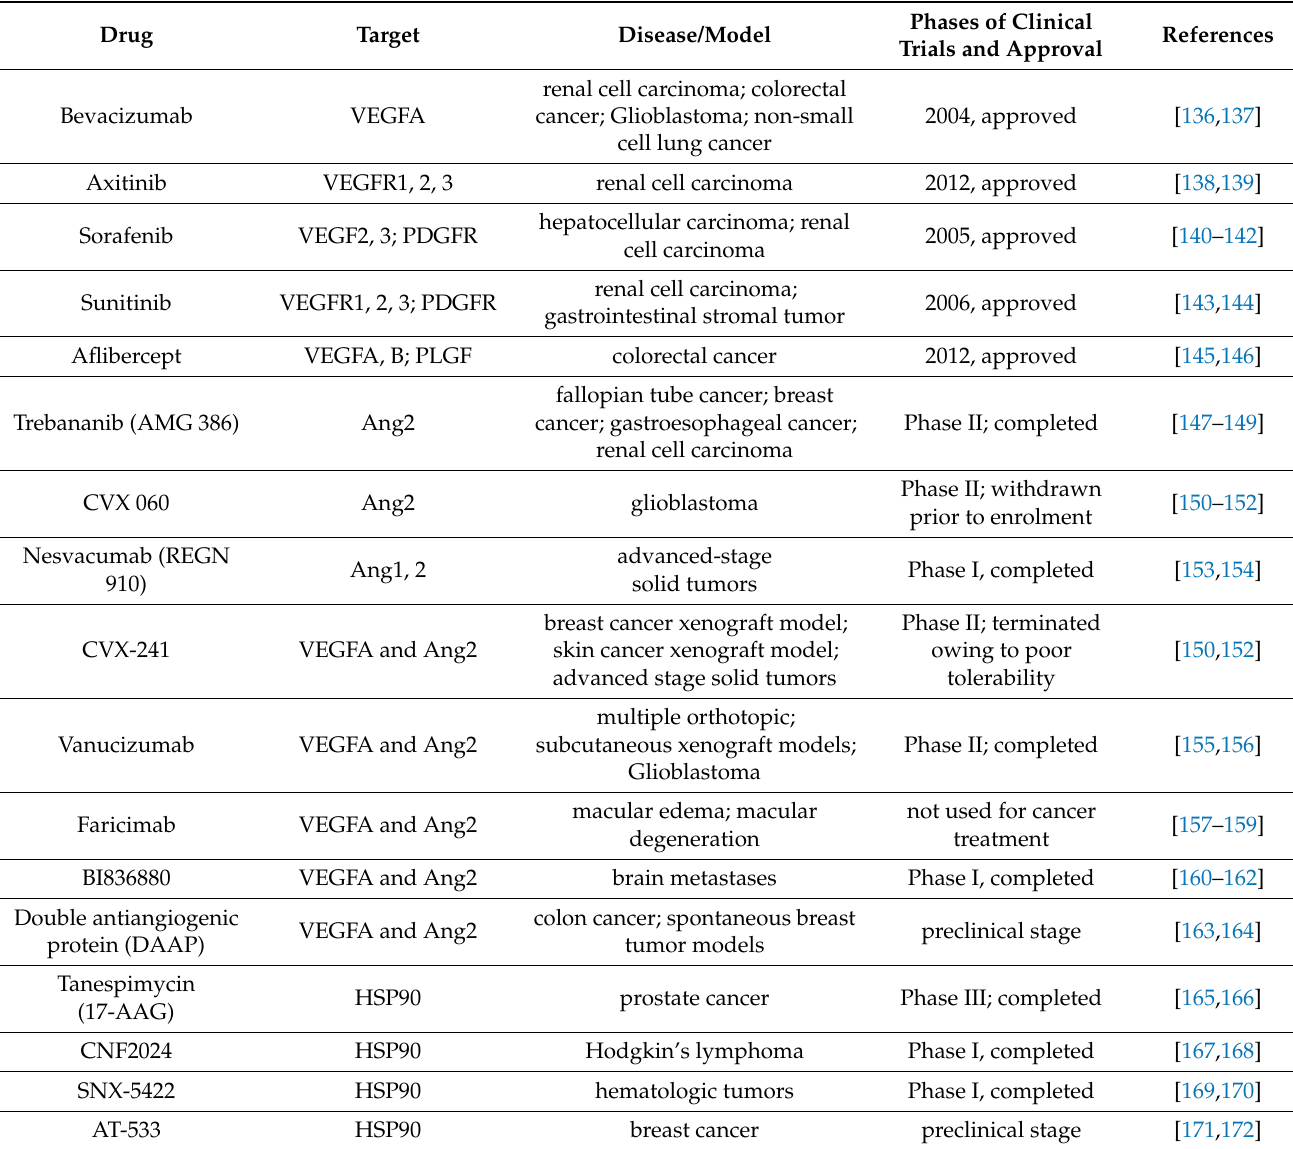
Table 1. Antiangiogenesis